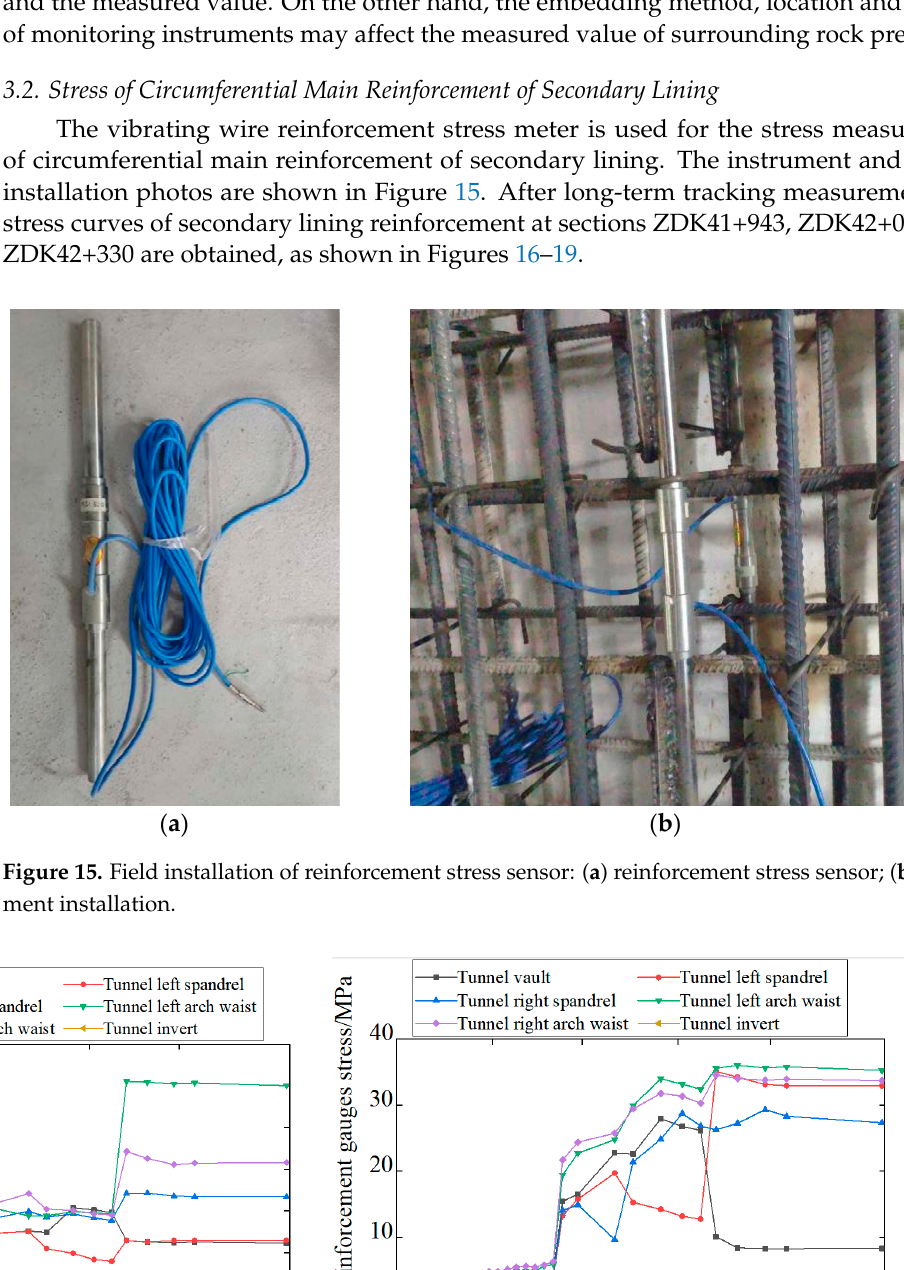
Figure 16. The time ‐ history curve of reinforcement stress in the ZDK41+943 section: ( a ) reinforce ‐ ment meter near the initial support side; ( b ) reinforcement meter away from the initial support side.